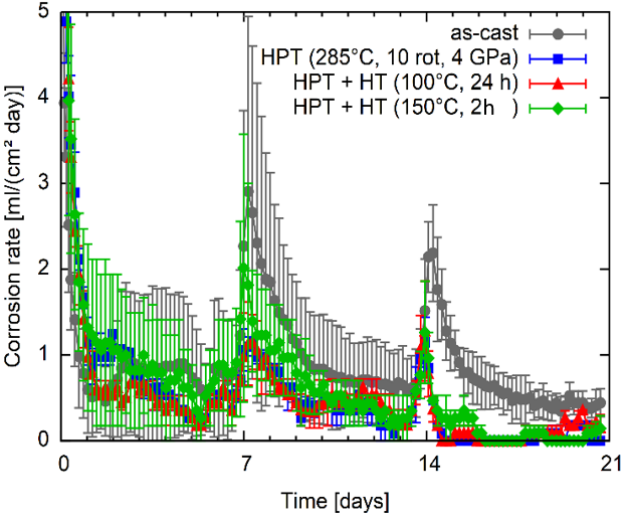
Figure 11. Corrosion rate of the Mg5Zn alloy in as-cast, HPT-deformed as well as subsequently heat-treated conditions as a function of the immersion time.